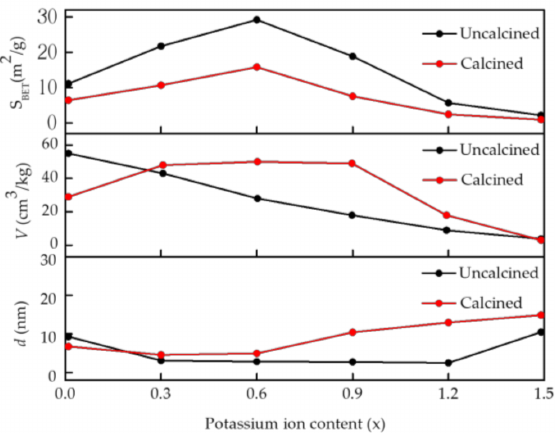
Figure 4. Specific surface area, pore volume and pore diameter of K x CsCuNH 4